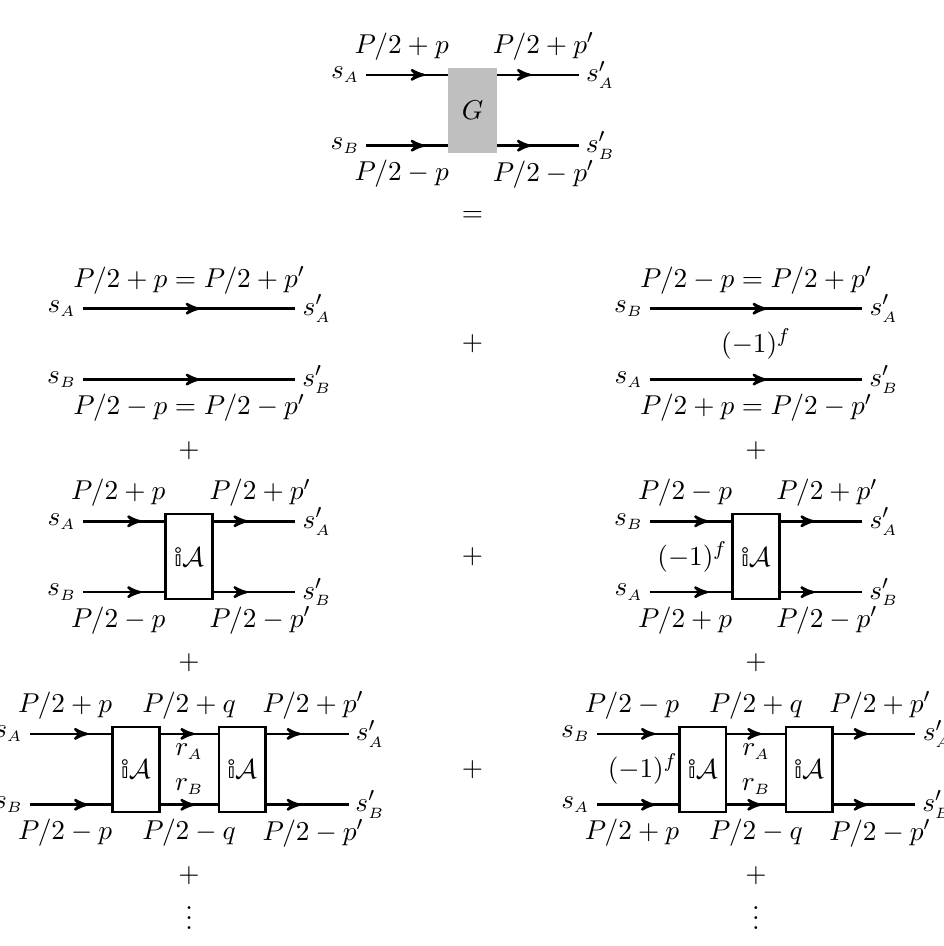
Figure 14 . Resummation of t -type ( left ) and u -type ( right ) 2PI diagrams for pairs of identical particles. Summation over r , r and integration over q is implied. The u -type diagrams carry A B extra factors ( − 1) f with respect to their t -type counterparts, where f = 0 or 1 if the interacting particles are bosons or fermions respectively, due to the different number of fermion permutations needed to perform the Wick